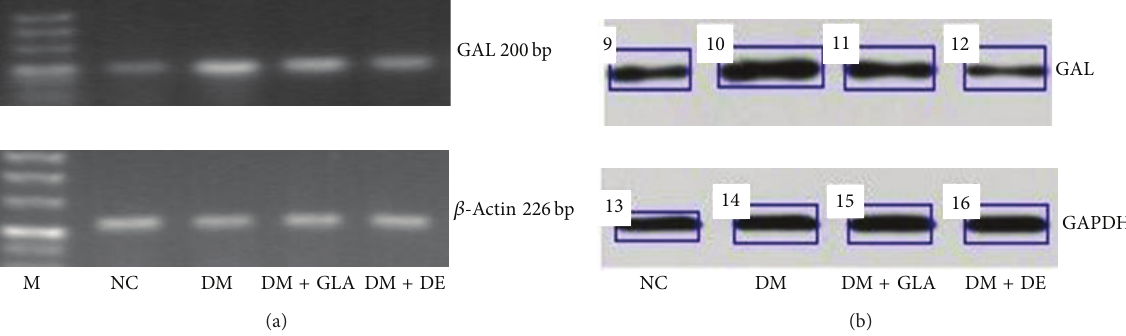
Figure 2: (a) PCR electrophoretogram of GAL mRNA and 𝛽 -actin, (b) the expression of GAL protein and GAPDH. (Note: DM for Diabetes group, DM + DE for detemir-treated diabetes group, DM + GLA for glargine-treated diabetes group, NC for normal control group, and M for